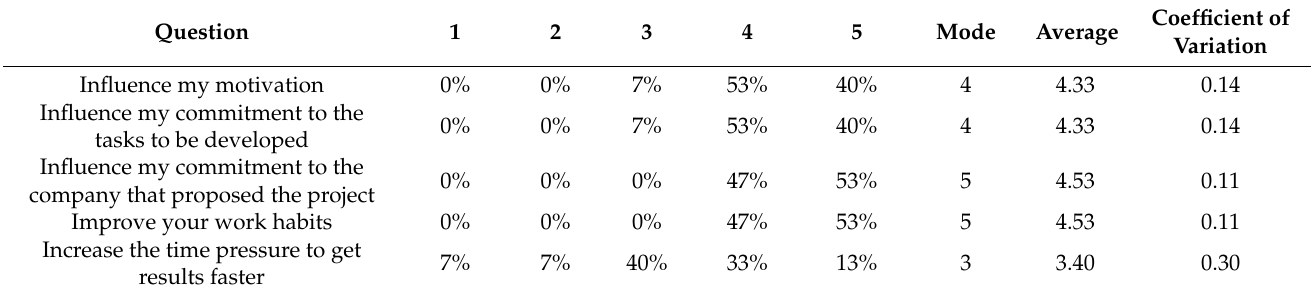
Table 3. External proposed project vs. students’ motivation and